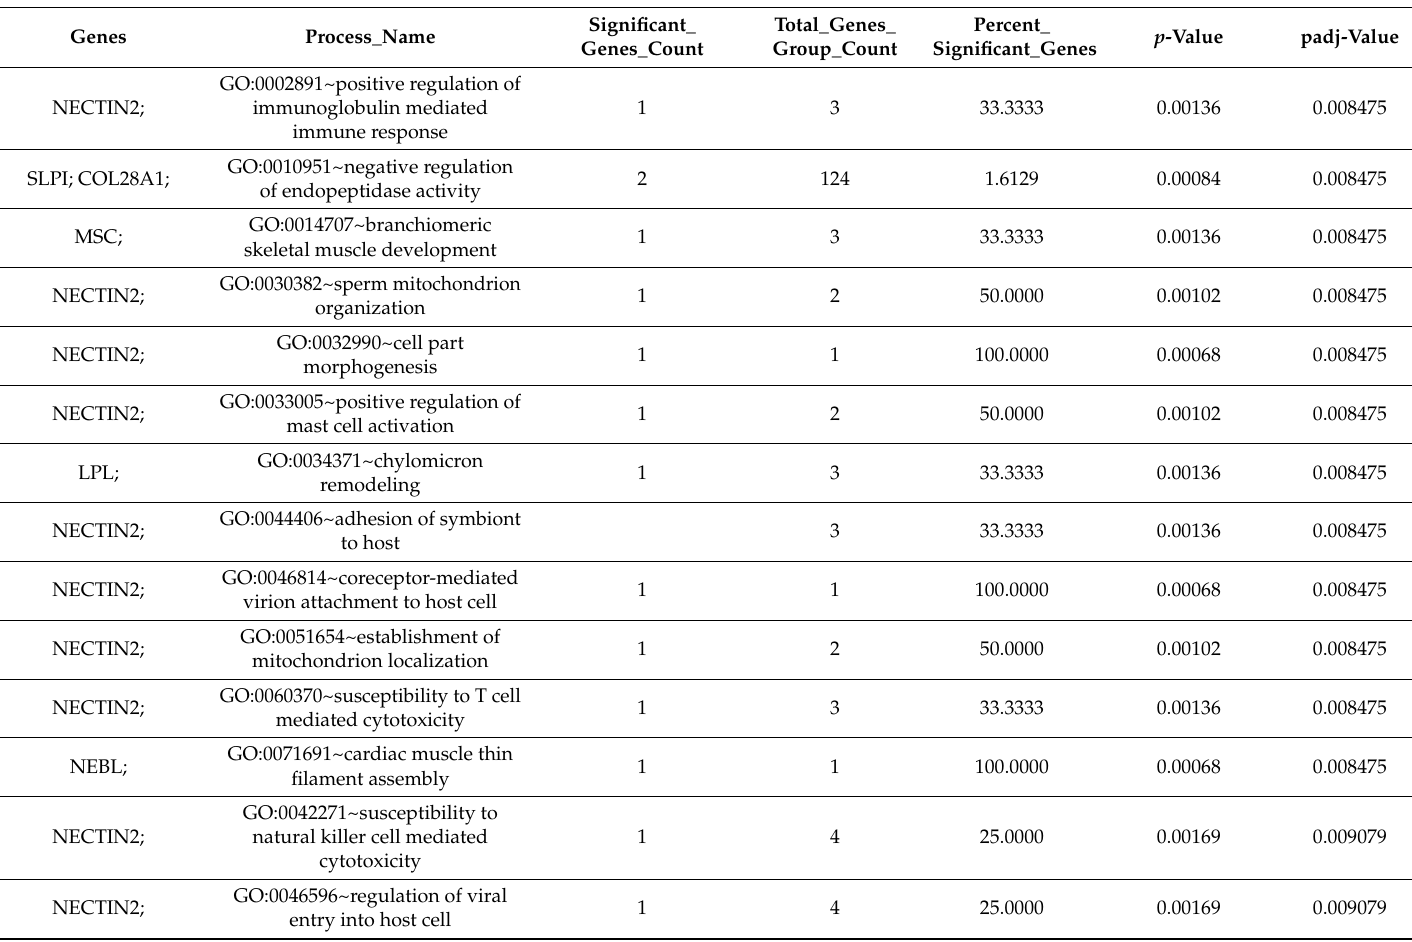
Table 5. The 20 most significant di ff erent pathways between HD gene carries with depression and HD gene carriers without